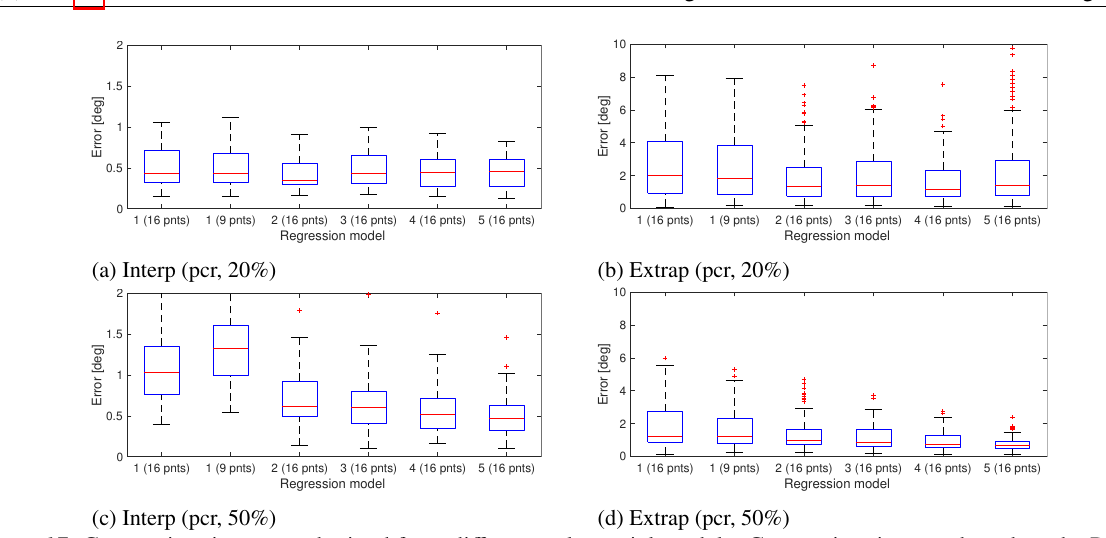
Figure 17 . Gaze estimation error obtained from di ff erent polynomial models. Gaze estimation was based on the PCR feature. Resolution of the eye image is set to 1280 × 960 and a noise level of 0 . 5 is applied. Errors are measured in degrees of visual angle.